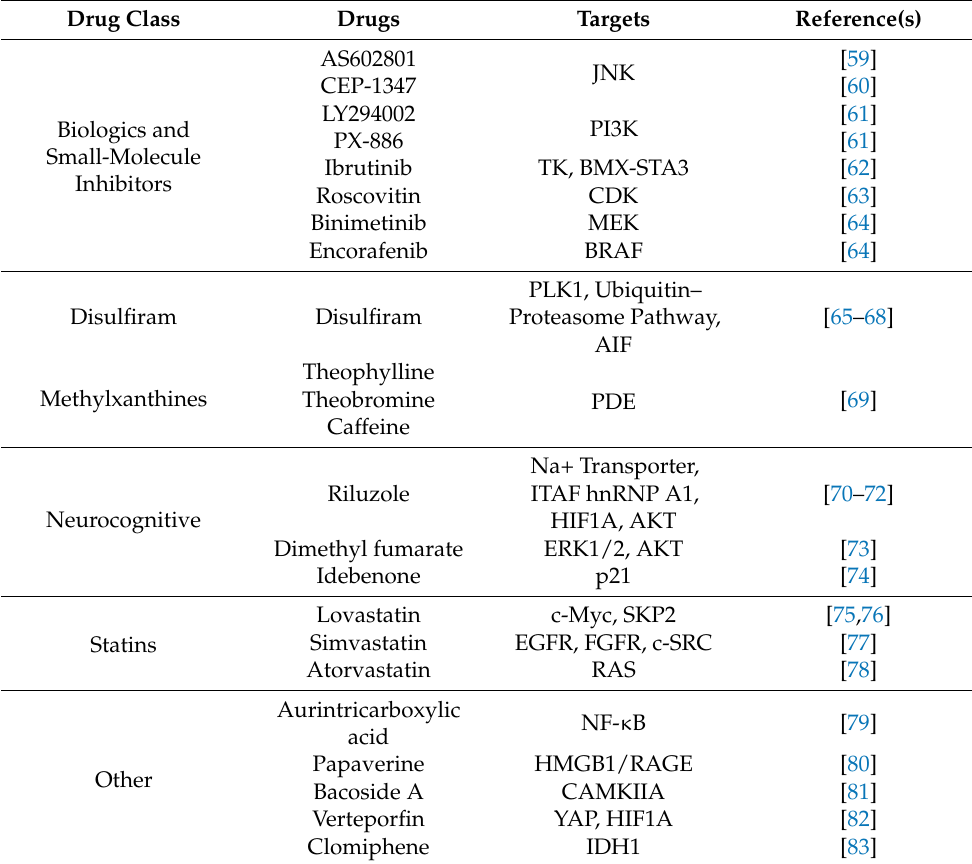
Table 1. Cont. Drug Class